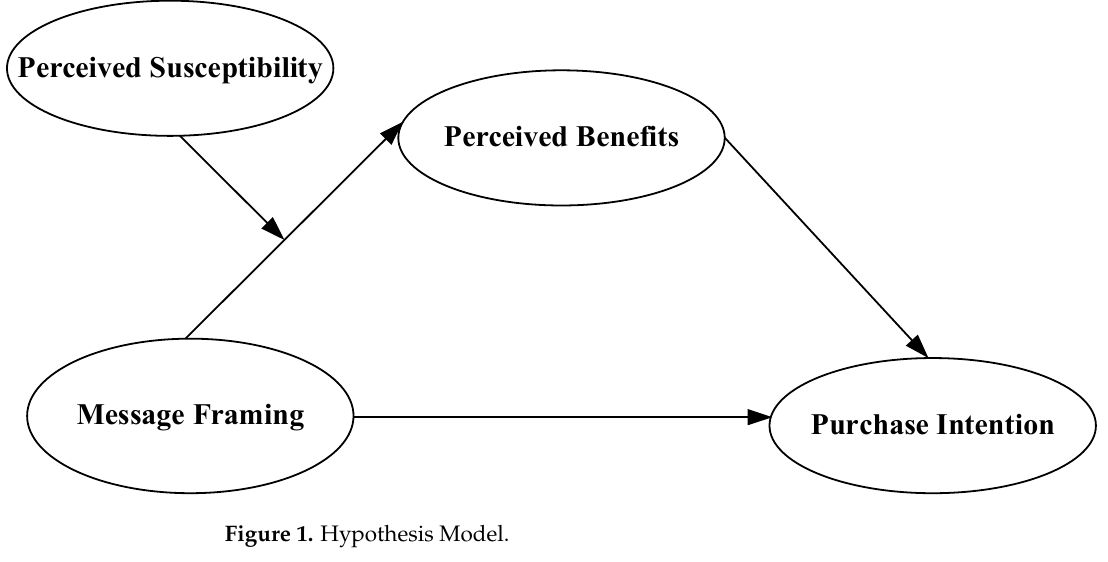
Figure 1. Hypothesis Model.